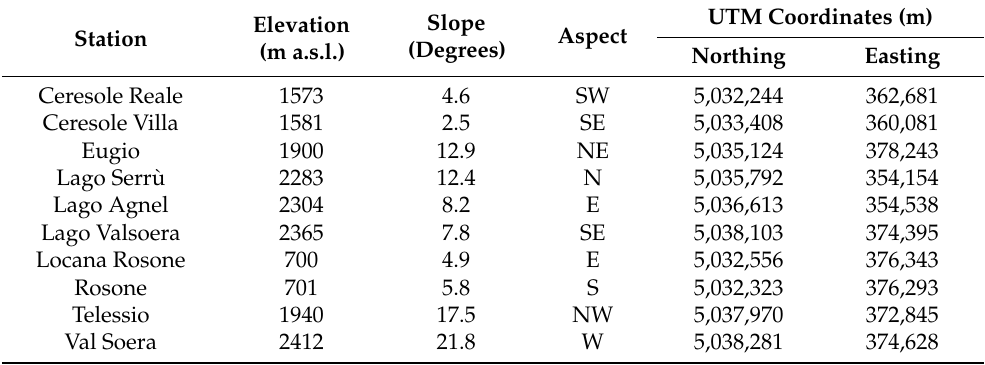
Table 3. Location and topographic features of the weather stations used for validation (CRS: WGS84 UTM 32N). Fl = Flat, N = North, NE = North-East, E = East, SE = South-East, S = South, SW = South-West, W = West, NW = North-West. UTM Coordinates (m) Slope Elevation Aspect Station (Degrees) (m a.s.l.) Northing Easting Ceresole Reale 1573 4.6